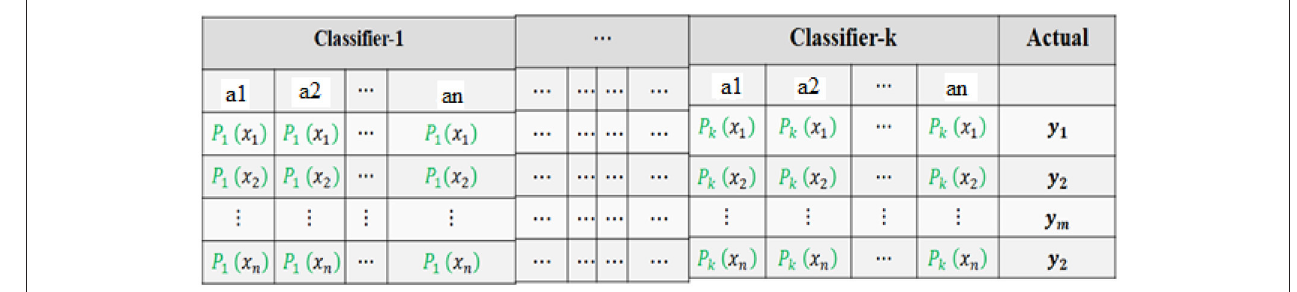
FIGURE 4 | Level-1 classifier input set.